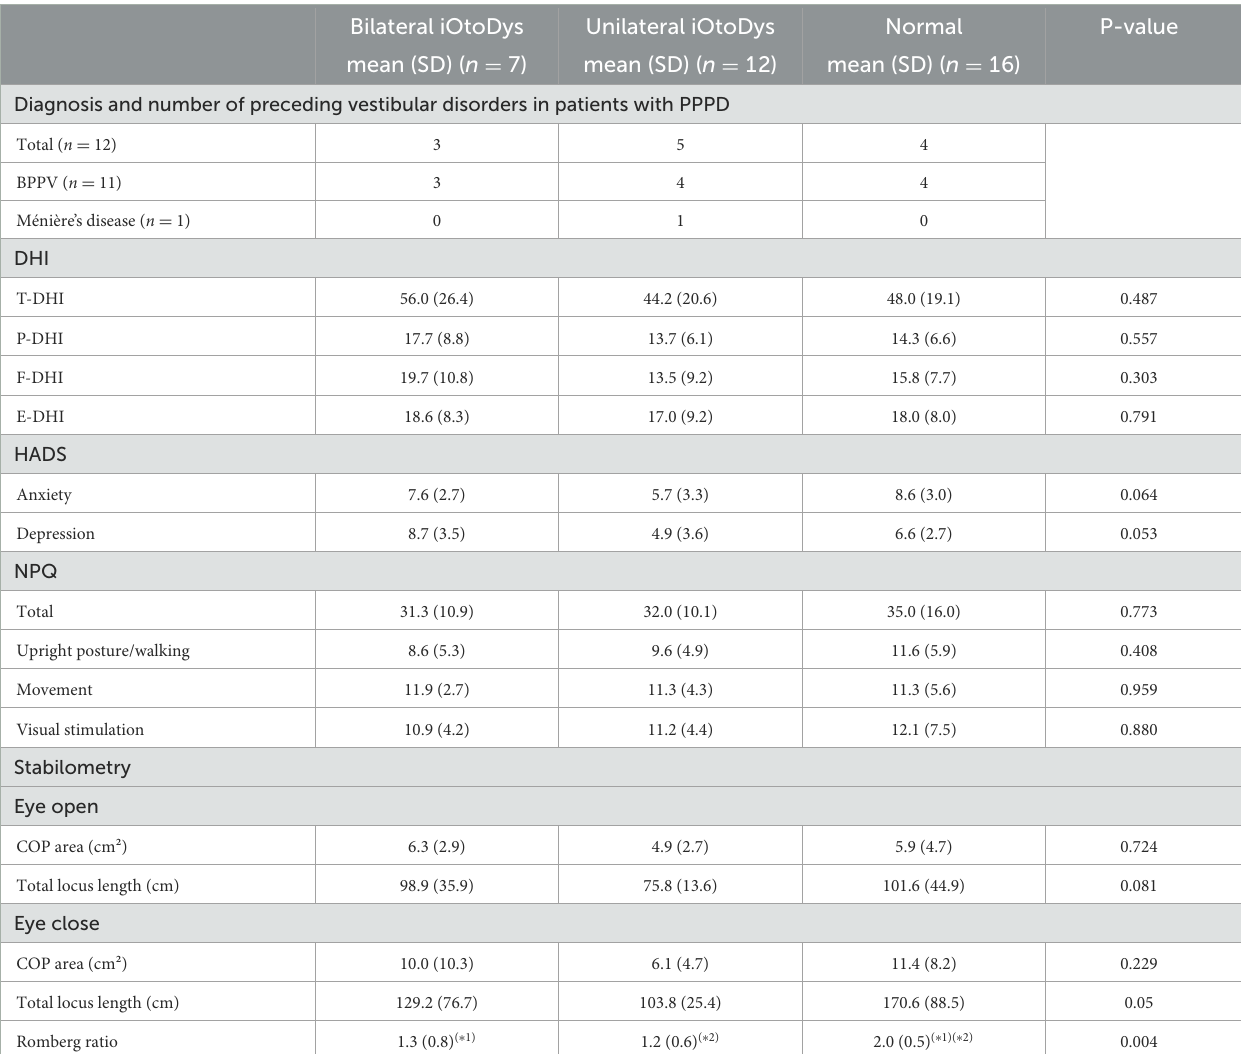
TABLE 4 Three-group comparison of the bilateral iOtoDys, unilateral iOtoDys, and normal groups. Bilateral iOtoDys Unilateral iOtoDys Normal P-value mean (SD) ( n = 7) mean (SD) ( n = 12) mean (SD) ( n = 16) Diagnosis and number of preceding vestibular disorders in patients with